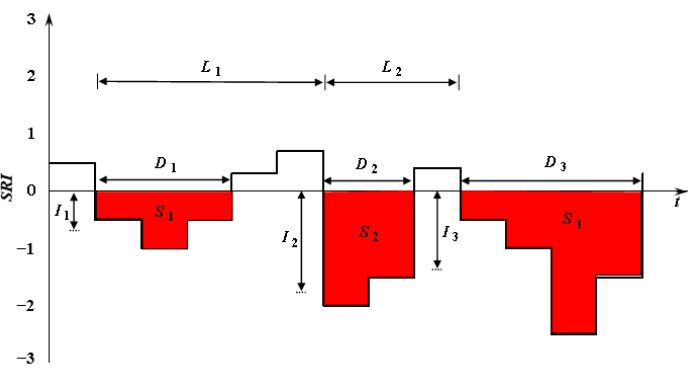
Figure 1. Definition of drought characteristics using Run Theory.